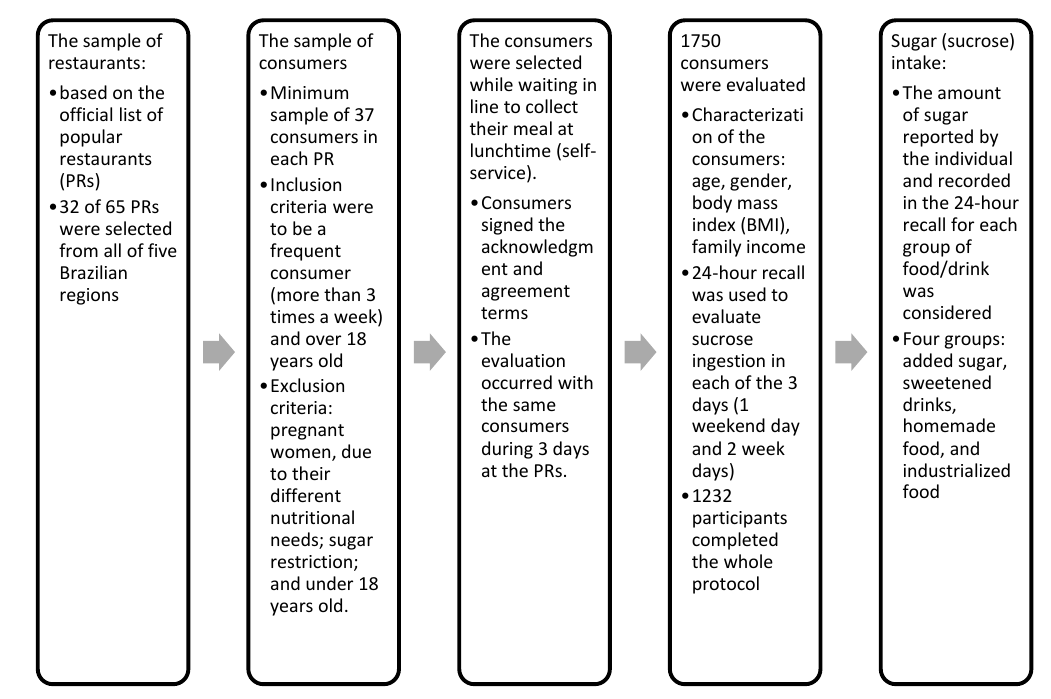
Figure 1. Study design and data collection.